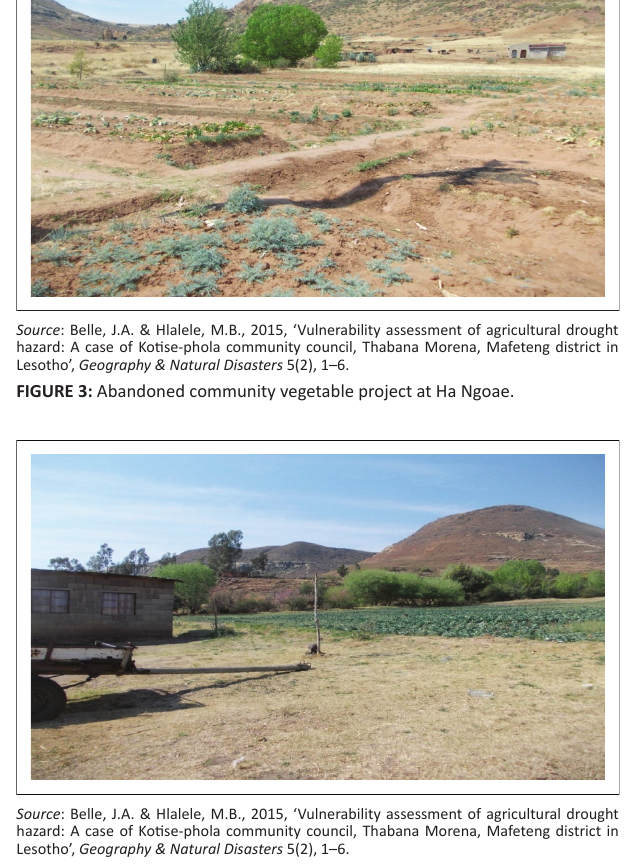
FIGURE 4: Mr Matea’s cabbage field at Ha Bofihla, Thabana Morena